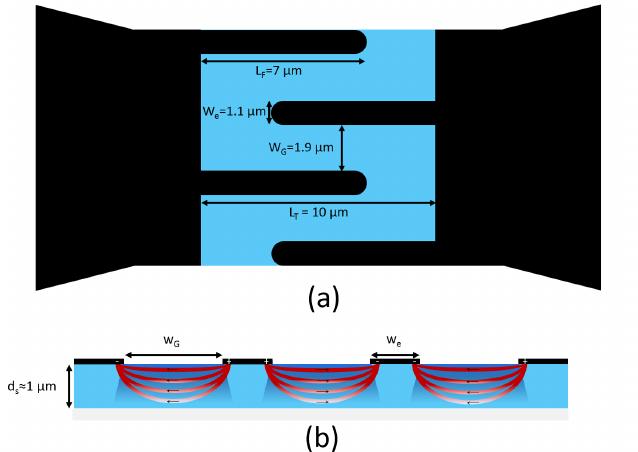
Figure 1. Geometric layout of the finger electrode (black) structure on the photoconductive material (blue) with geometric variables as defined in the text: ( a ) Top view ( b ) Cross-sectional view (red lines depict the field lines across the